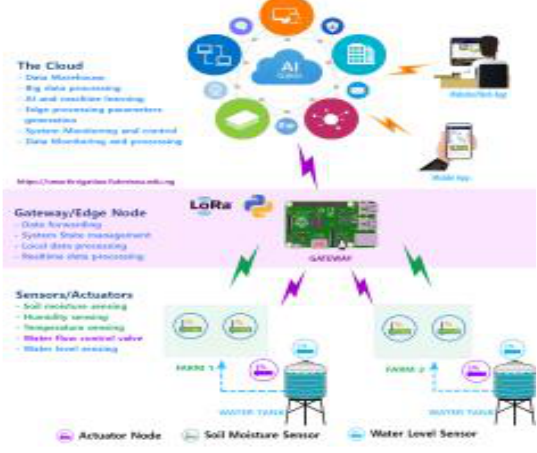
Figure 14 . Automated smart irrigation conceptual diagram